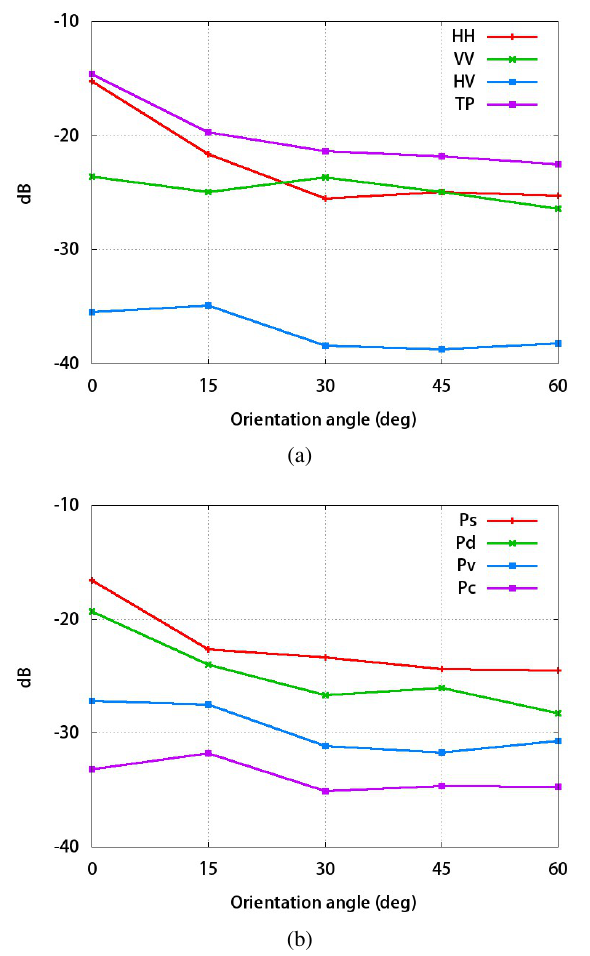
Figure 4. Scattering of the concrete blocks under different orientation angles. (a) HH , V V , HV and TP , and (b) P s , P d , P v and P